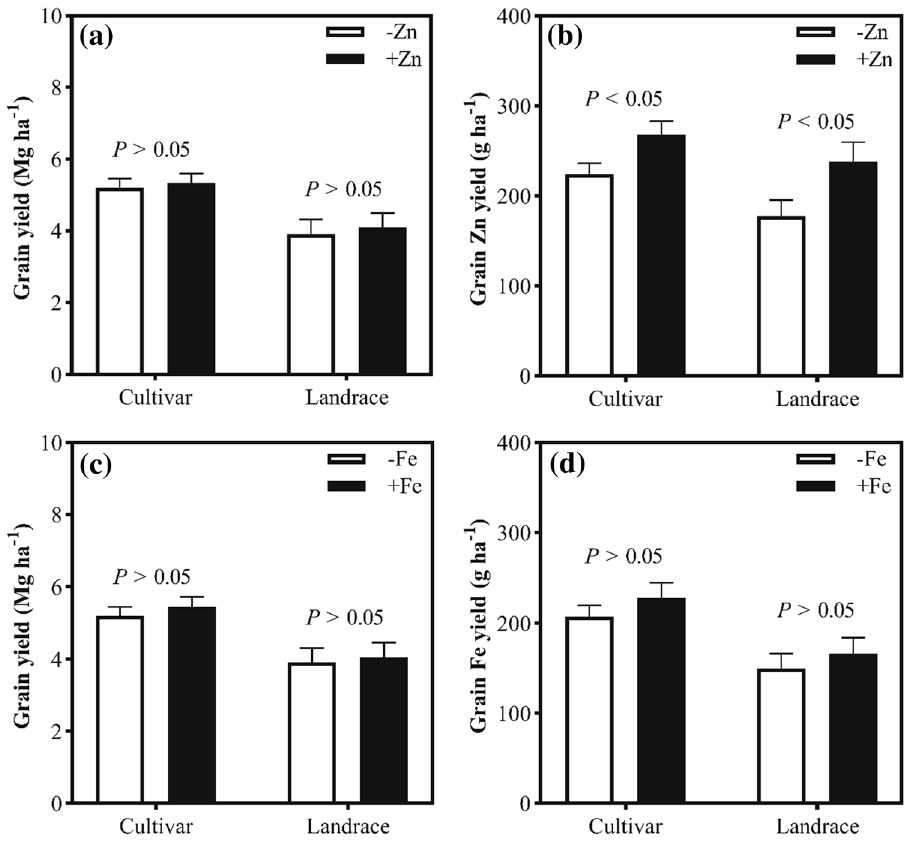
Figure 6. Comparison of ( a ) grain yield and ( b ) grain Zn yield between + Zn and –Zn treatment in Experiment II and ( c ) grain yield and ( d ) grain Fe yield between + Fe and –Fe treatment in Experiment III for wheat cultivars and landraces.